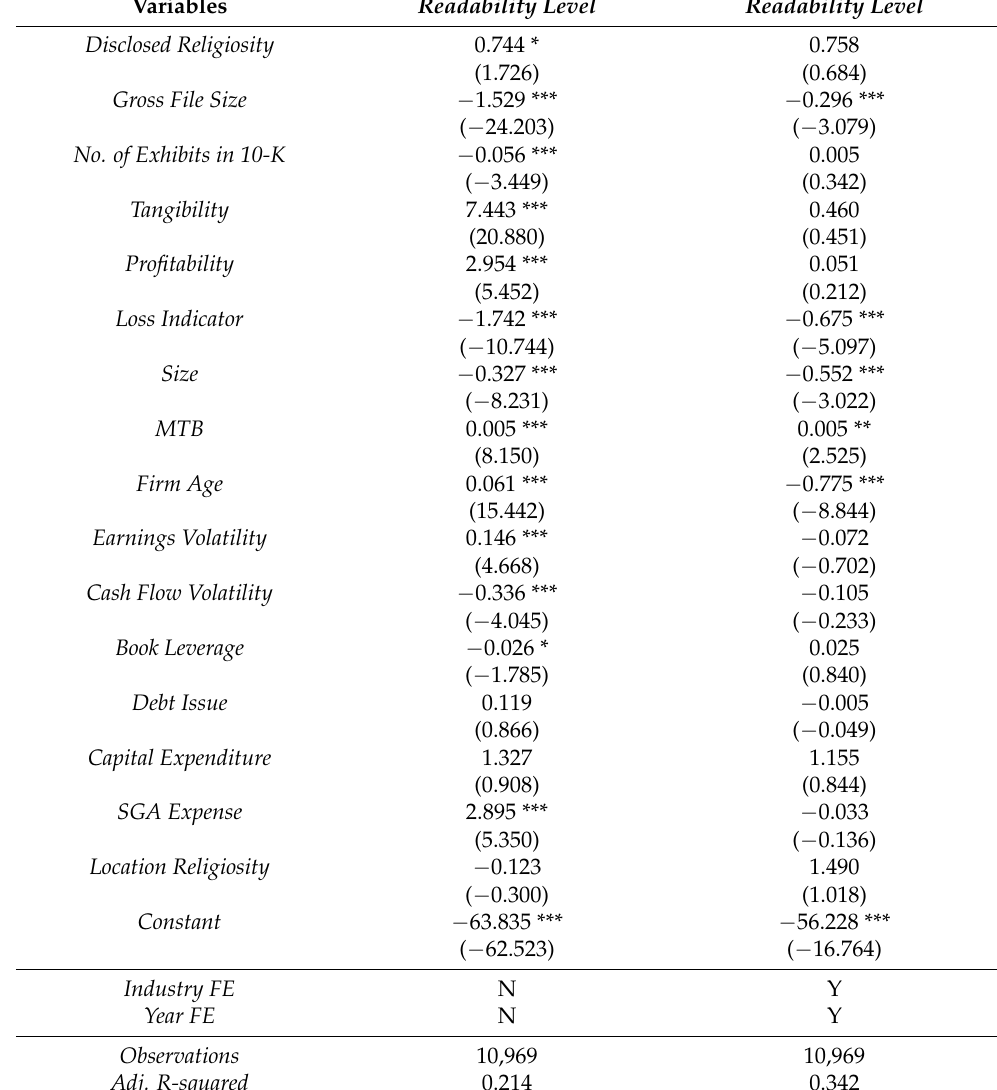
Table 6. Impact of Executive Level Religiosity on Annual Report Readability—Non-Christian Reli- gious